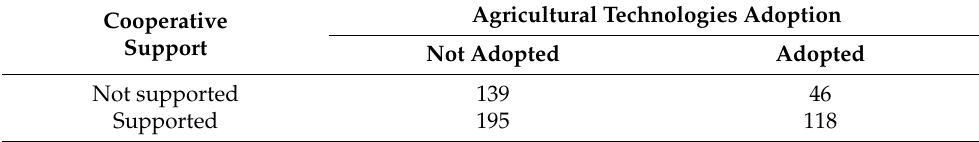
Table 2. Samples distribution in four